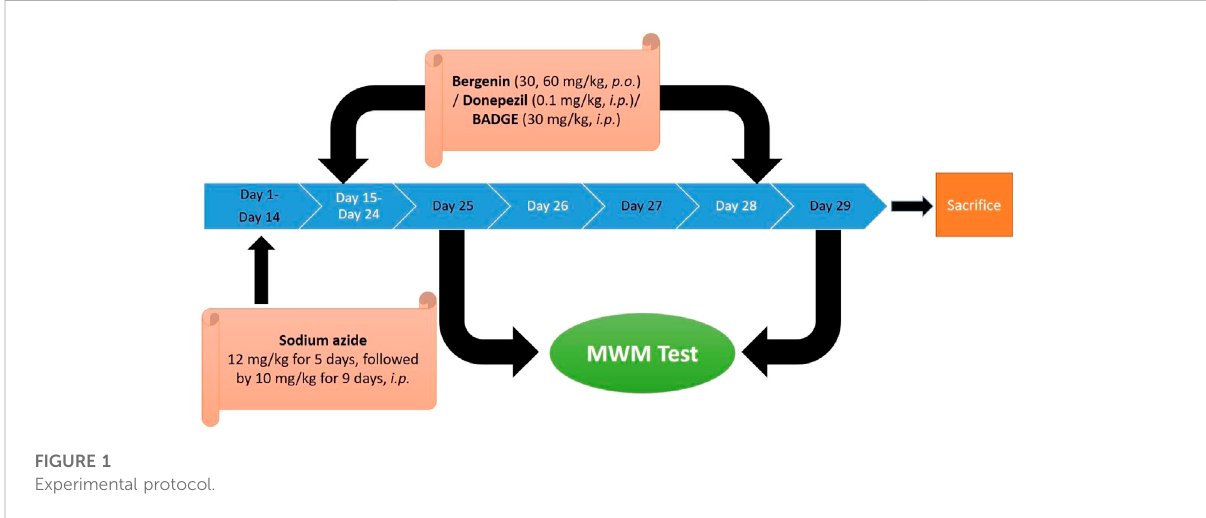
FIGURE 1 Experimental protocol.